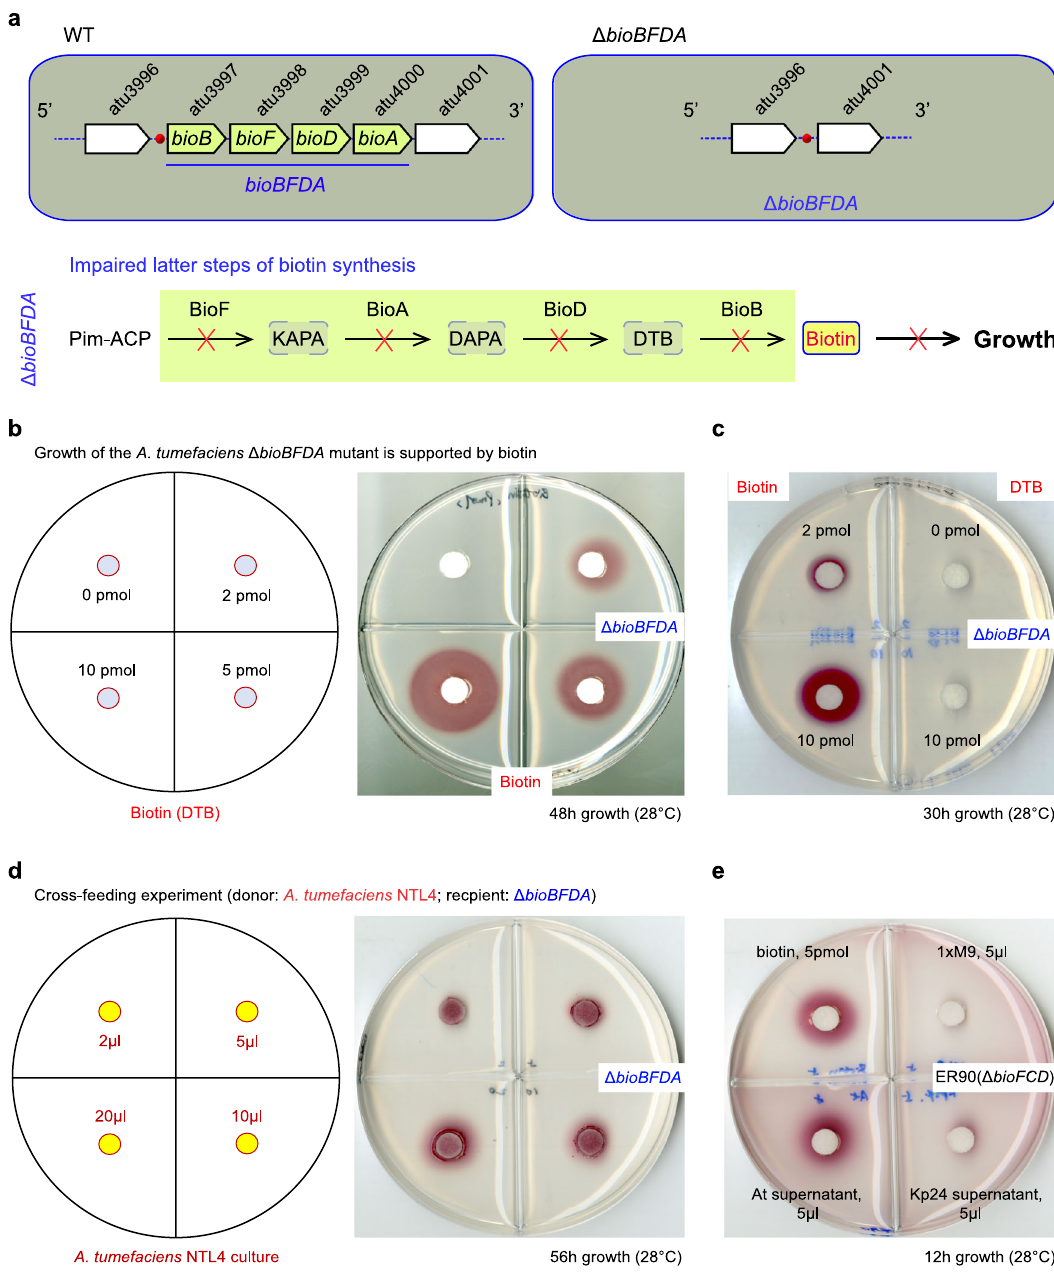
Fig. 1 Requirement of biotin for Agrobacterium growth. a Schematic illustration of the biotin-auxotrophic strain of A. tumefaciens ( Δ bioBFDA ). The removal of biotin operon bioBFDA from A. tumefaciens NTL4 interrupts the biotin synthesis pathway of A. tumefaciens , and therefore interferes bacterial growth on the condition without the supplementation of exogenous biotin. b Growth rescue of the Δ bioBFDA mutant by the addition of exogenous biotin. c Unlike biotin, its precursor dethiobiotin (DTB) fails to allow the Δ bioBFDA mutant to appear on the nonpermissive growth condition without any biotin. d The growth of the Δ bioBFDA mutant on the biotin-lacking medium is restored by the cross-feeding with the wild-type strain of A. tumefaciens NTL4. e The cell- free growth culture (i.e., supernatant) of A. tumefaciens NTL4, (rather than the negative control, Klebsiella pneumoniae strain 24) cross-feeds the biotin auxotroph ER90 ( Δ bioFCD ) of E. coli . Here, the A. tumefaciens NTL4 was pelleted and then suspended with 1× PBS. It indicated that A. tumefaciens NTL4 secrets biotin (mostly its DTB precursor) into the growth medium/environment 39 . The strain FYJ283 ( Δ bioBFDA ) 39 appeared as an indicator strain in the biotin (DTB) bioassay ( b – c ), and also acted as a recipient strain in the cross-feeding experiment of A. tumefaciens NTL4 ( d ). The biotin/DTB